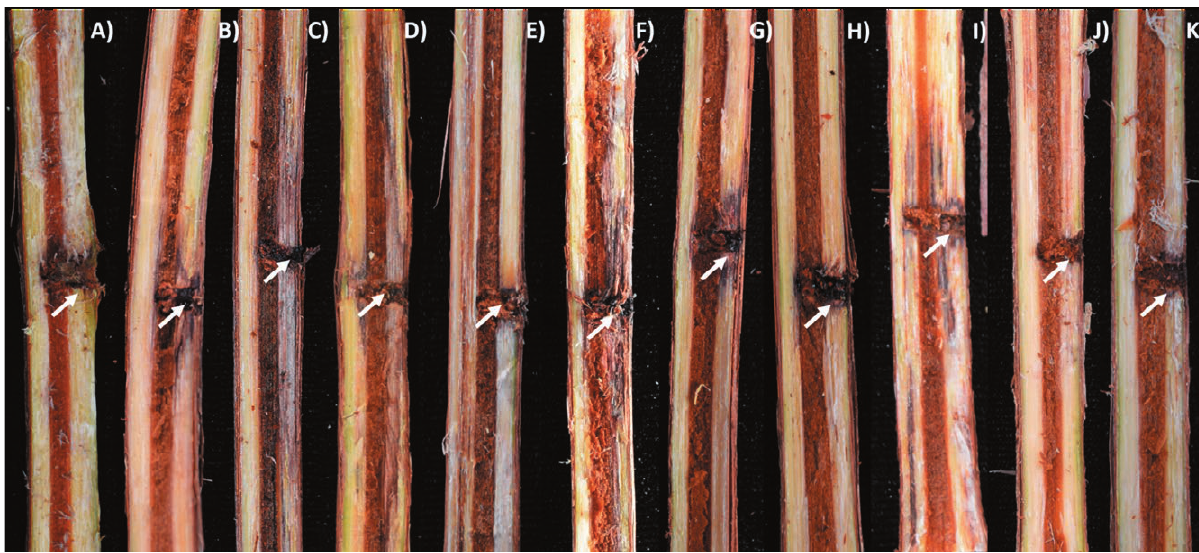
Figure 6. Grapevine woody shoots showing dark-brown lesions at 2-months post inoculation with Lasiodiplodia isolates . A) Control plant (PDA), B) L. gilanensis UCD256Ma, C) L. brasiliensis MXBCL28, D) L. brasiliensis MXVS18, E) L. brasiliensis MXVS16a F) L. gilanensis MXBCCS01, G) L. gilanensis MXBC50, H) L. exigua MXVS6a, I) L. exigua MXVS21b J) L. crassispora MXVS1b, and K) L. crassispora MXB- CV5. White arrows indicate the point of inoculation.